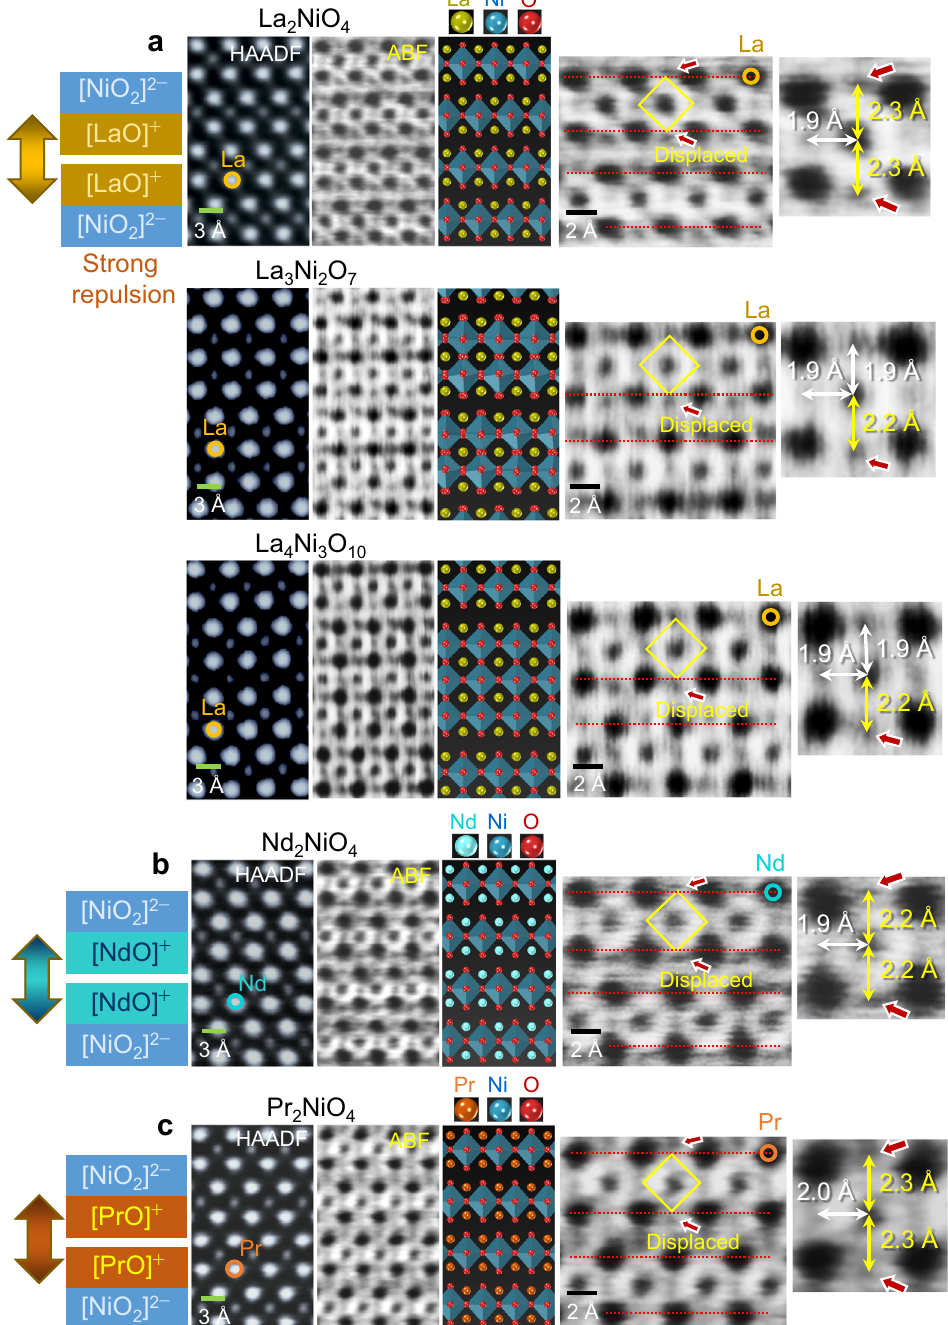
Fig. 6 STEM images showing the structure of lanthanide-based RP nickelates. Atomic-column-resolved images were acquired in a La 2 NiO 4 , La 3 Ni 2 O 7 , and La 4 Ni 3 O 10 , b Nd 2 NiO 4 , and c Pr 2 NiO 4 , as listed in Supplementary Table 3. Strong local repulsion between [LnO] + sublayers is illustrated in the left- hand column. Signi fi cant elongation of the Ni – O bonds at the shear planes is denoted by yellow arrows in the ABF images, providing quantitative information on the bond lengths. Red arrows in each image indicate substantial displacement of oxygen